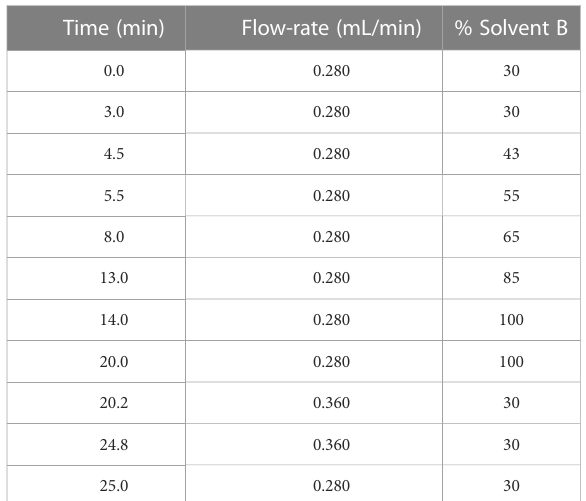
TABLE 2 LC gradients and fl